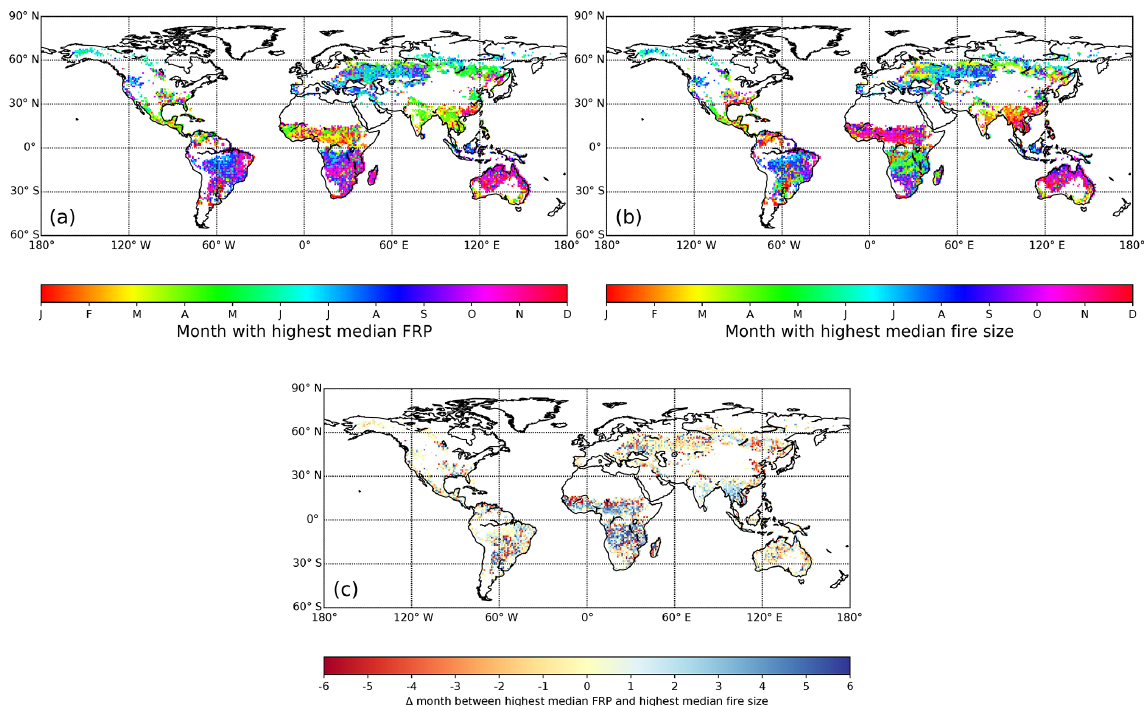
Figure 4. Month with the highest median fire radiative power (FRP, a ), highest median FS ( b ) and the difference between the two ( c ). In blue cells, the month with the largest fire events happens before the month with the most intense fires. In red cells, the month with the largest fire events happens before the month with the most intense fires. In yellow cells, the months with the largest fires and with the most intense fires are the